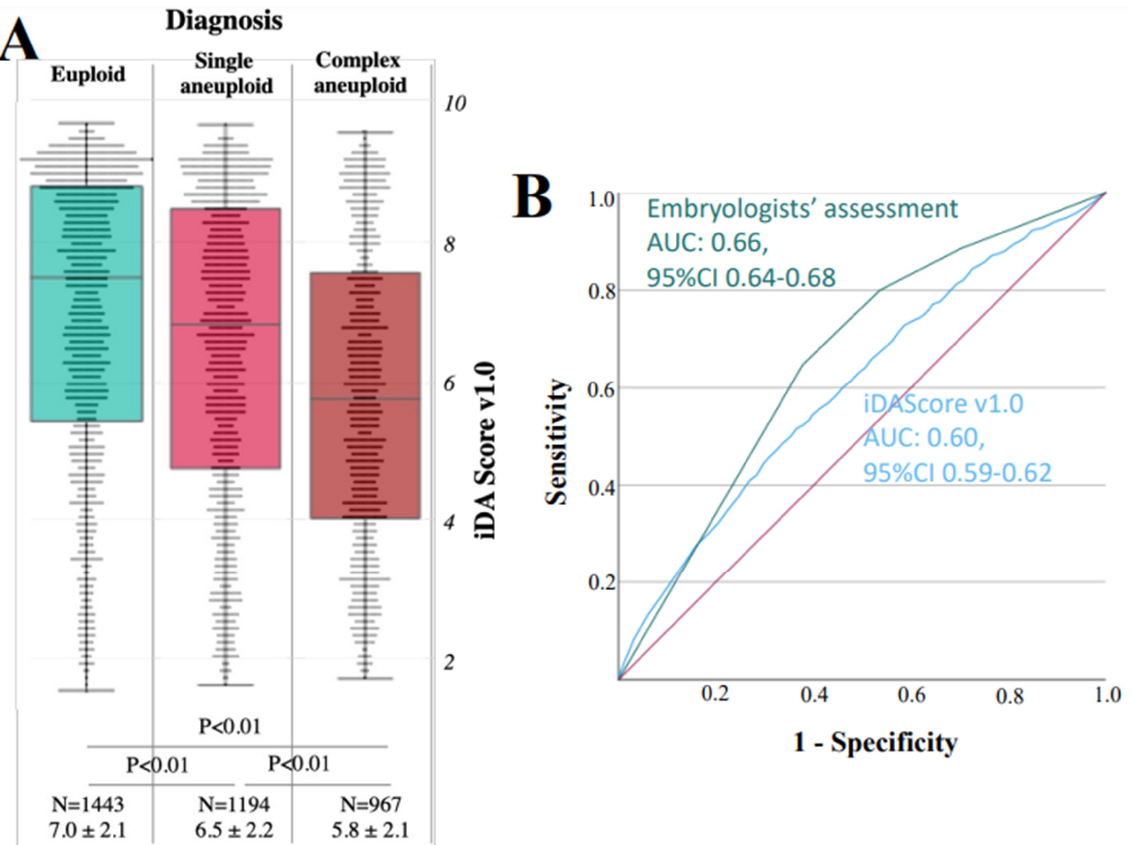
Figure 5. iDAScore v1.0 is associated with blastocysts’ chromosomal constitution, but the AUC is 0.60. ( A ) Association between iDAScore v1.0 and blastocysts’ chromosomal constitution clustered as euploid, single aneuploid, or complex aneuploid; ( B ) Receiver operating characteristic (ROC) curve analysis. The green curve represents the discrimination of embryologists’ assessment upon euploidy with an area under the curve (AUC) of 0.66, while the blue curve represents the discrimination of iDAScore v1.0 upon euploidy with an AUC of 0.60. Table 1. Logistic regressions for the association between iDAScore v1.0 with euploidy (adjusted for maternal age) and live birth (LB) after euploid single embryo transfer (SET).